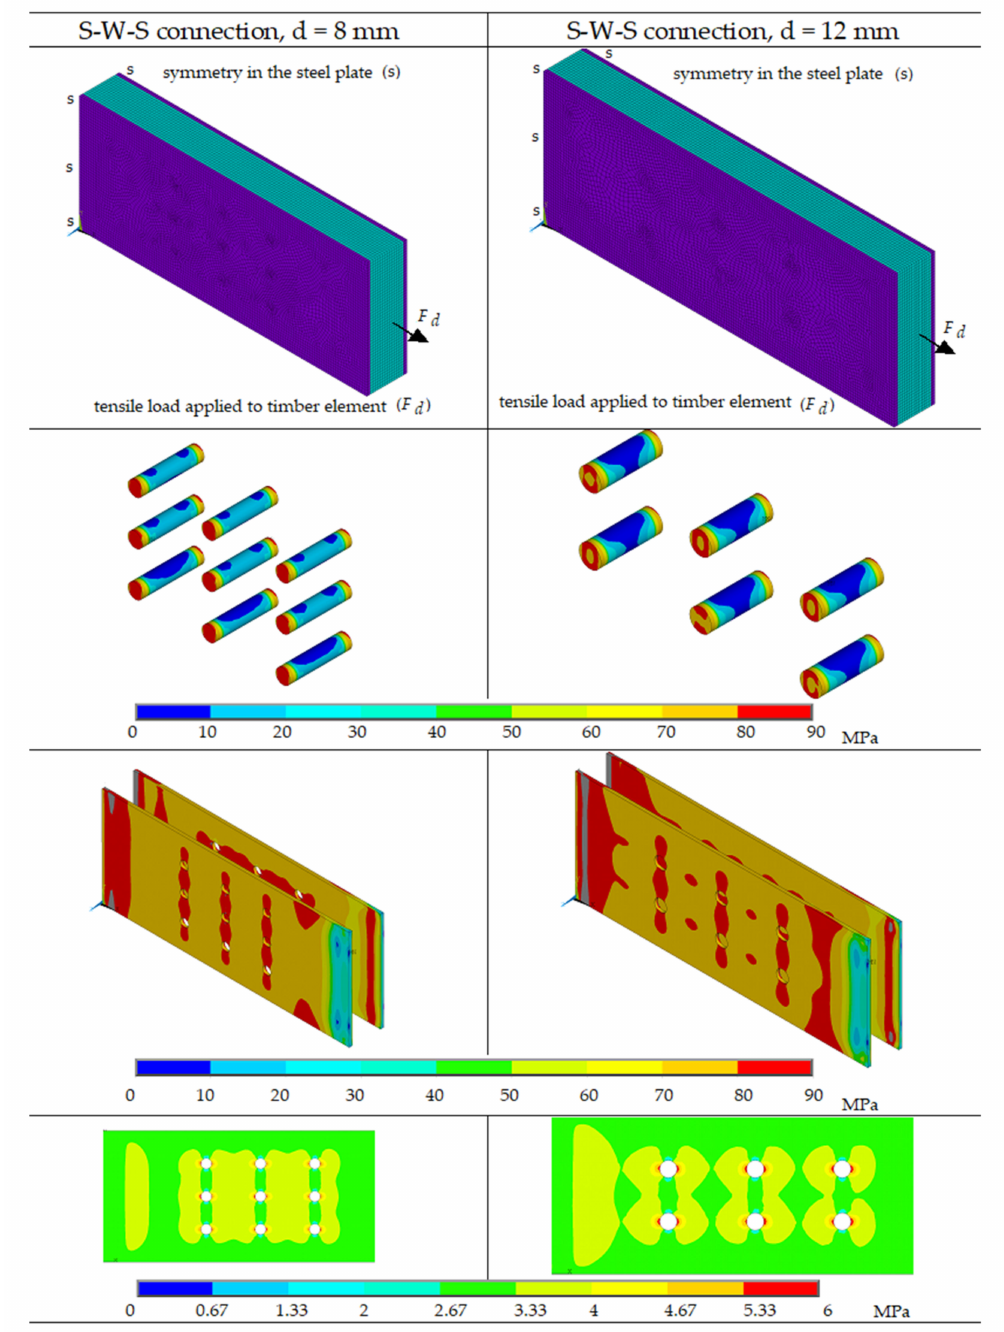
Figure 5. S-W-S connection ( t 2 = 27.5 mm, d = 8 and 12